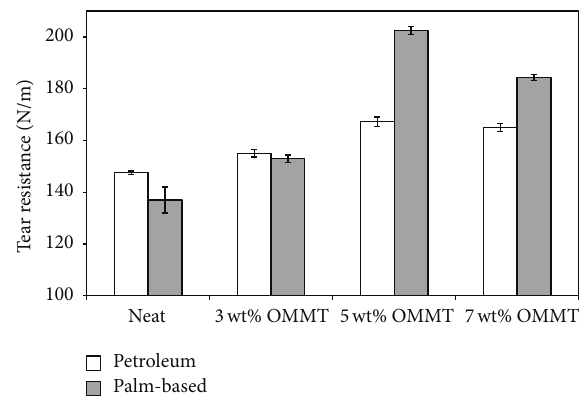
Figure 6: FTIR spectra of (a) neat petroleum PU foam and PU nanocompositefoamswith(b)3 wt%OMMT,(c)5 wt%OMMT,and (d) 7wt% OMMT.